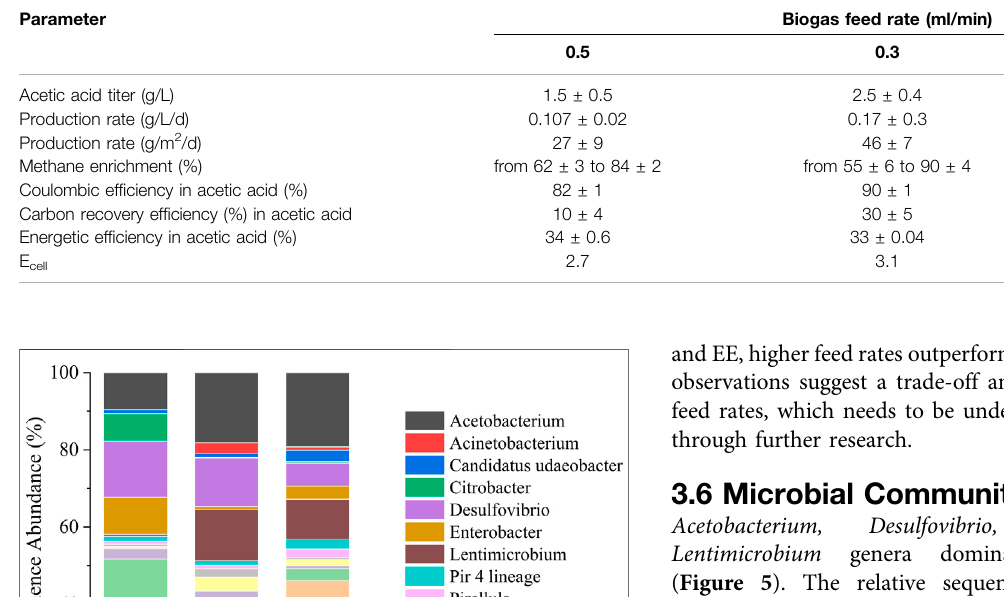
( Figure 5 ). The relative sequence abundance of different